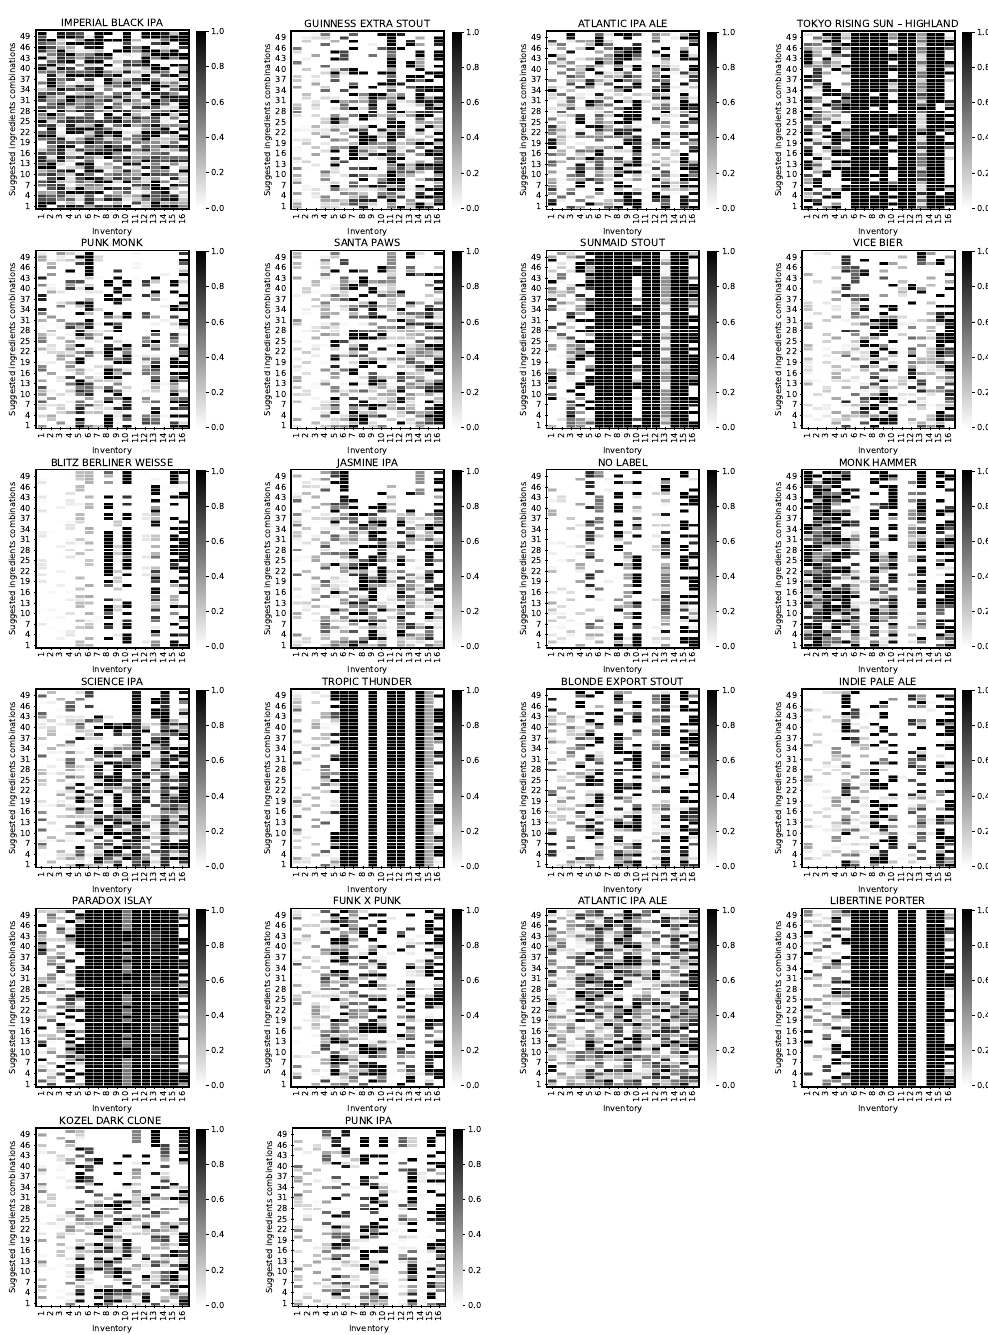
Figure A1. Ingredients combinations generated by the system. This illustrates the recommended ingredients uptake proportion and the independent solutions’ diversity for each